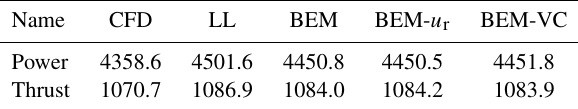
Table 2. The aerodynamic power (in kW) and thrust (in kN) of the rotor with baseline straight blades calculated using different aero- dynamic models. The operational condition is with a uniform wind speed of 8ms − 1 , rotational speed of 0.855rads − 1 and zero cone